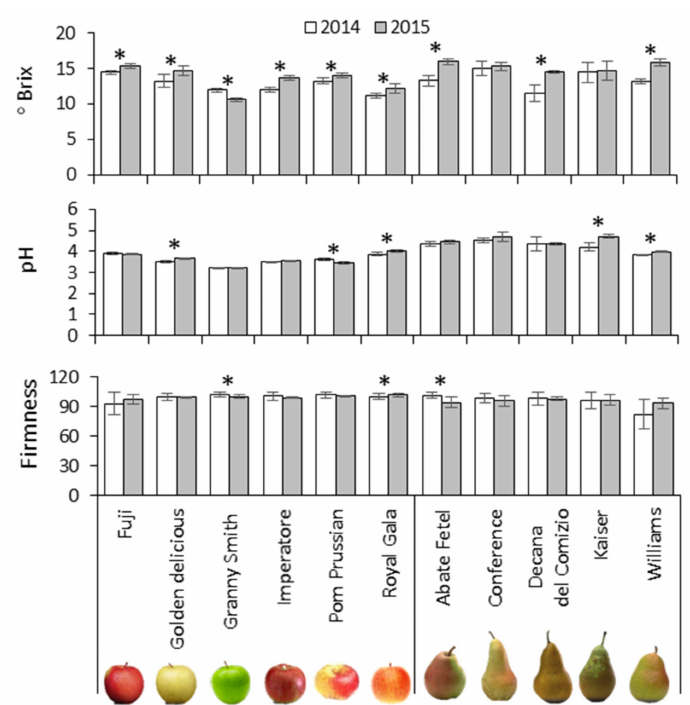
Figure 1. Agronomic features of the fruits from different apple and pear cultivars. Data are means of n = 30 individual fruits ± standard deviations. Significant differences between means of the two growing seasons for each variety are marked (*) for p < 0.01 according to Student’s t